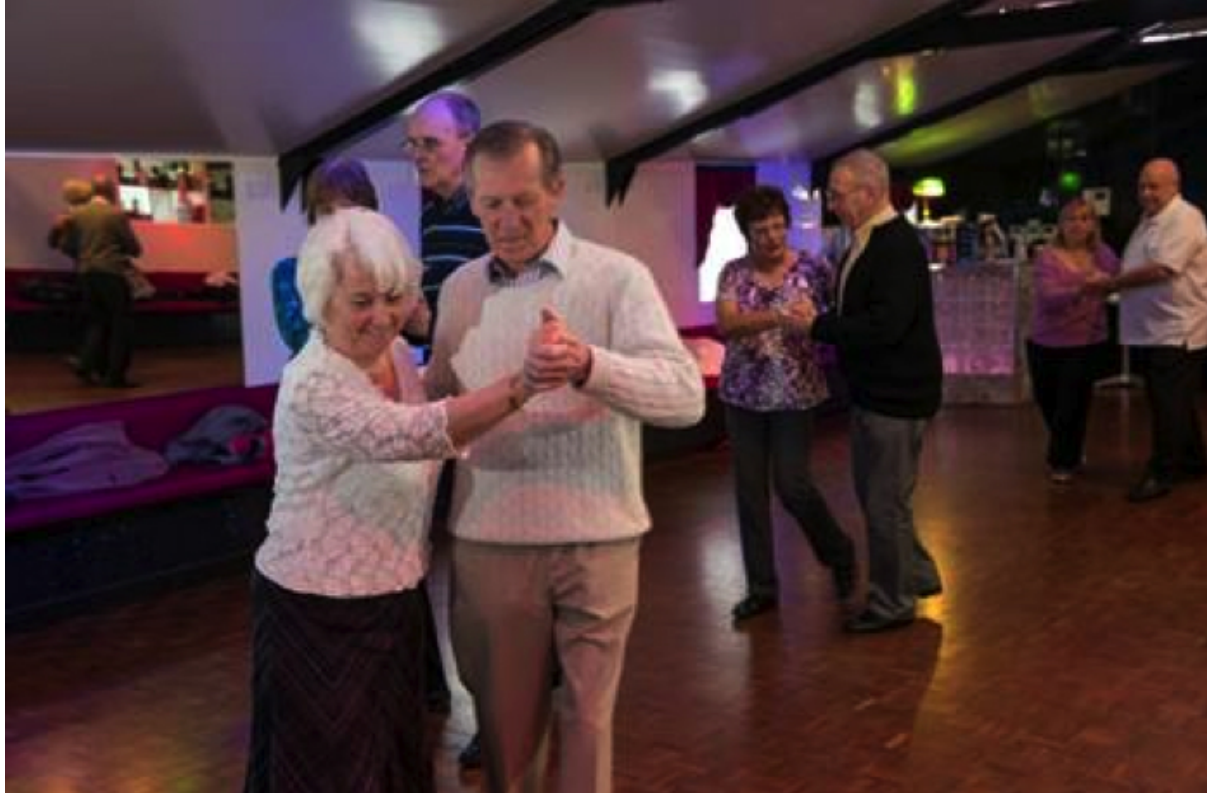
Figure 2. Participants enjoying a dance